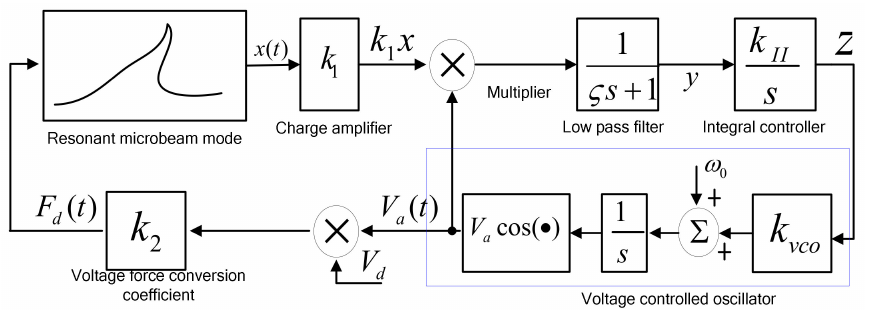
Figure 9. Frequency tracking control of resonant microaccelerometer. This rectangle represents voltage controlled oscillator